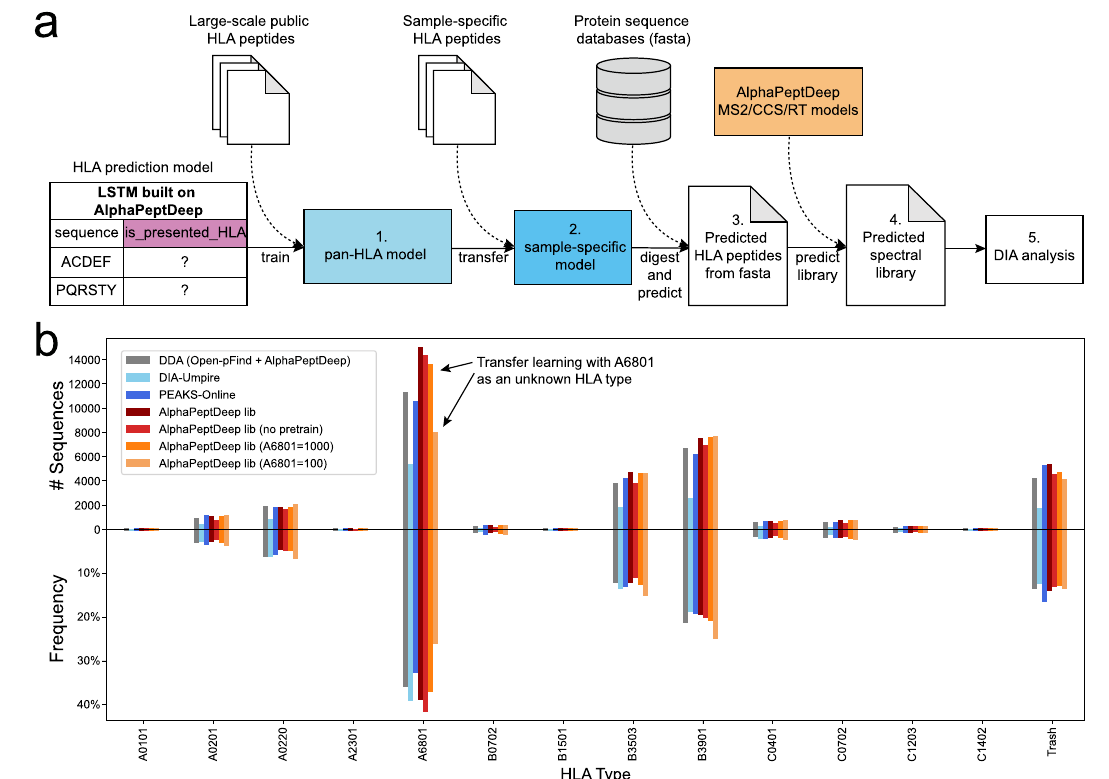
Fig. 6 | HLA prediction model built on AlphaPeptDeep functionalities. a The pipelinewiththeHLApredictionmodeltoextractpotentialHLApeptidesfromthe proteome databases. The HLA model is a binary classi fi er that predicts if a given sequence is a potentially presented HLA sequence. b Our HLA prediction model boosts the number of identi fi ed HLA-I peptides compared to other tools. Cell line HLA data from RA957 with sequence lengths from 8 to 14 were used. The top bar plotsshow the number of identi fi ed unique sequences of HLA allele typesfor each search method. The bottom bar plots the relative frequency of these HLA allele types. ‘ Trash ’ means the peptides cannot be assigned to any HLA allele types by MixMHCpred at 5% rank level. ‘ AlphaPeptDeep lib ’ (red) refers to the library pre- dicted by the sample-speci fi c HLA model and our MS2 and RT models. The